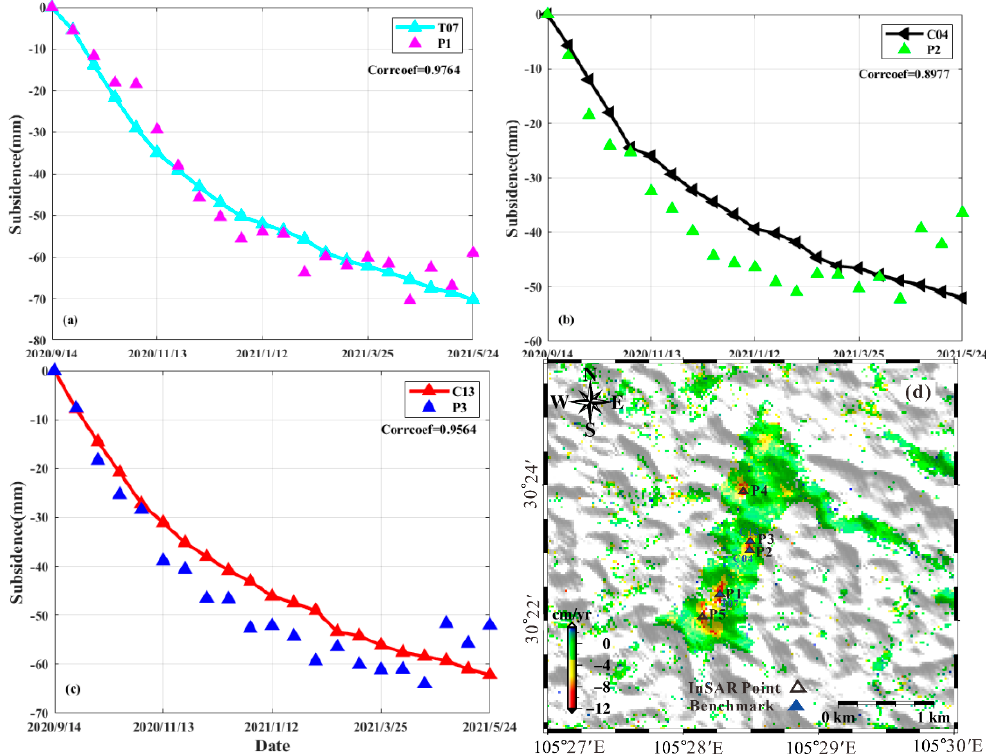
Figure 8. ( a ) Comparison subsidence of T07 and P1; ( b ) comparison subsidence of C04 and P2; ( c ) comparison subsidence of C13 and P3; ( d ) average subsidence rate from September 2020 to June 2021. Table 2. Validation of temporal InSAR monitoring